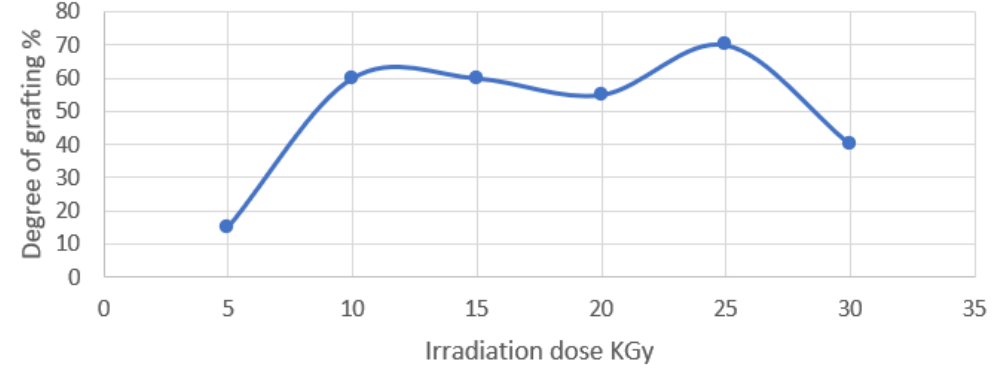
Figure 2. Irradiation dose impact on the polypropylene at an inhibitor concentration of 2.5 gm FeCl 3 by wt%, at a comonomer composition of 80/20 wt%, at a comonomer concentration of 60%, and a solvent concentration of 70% methanol and 30% H 2 O.